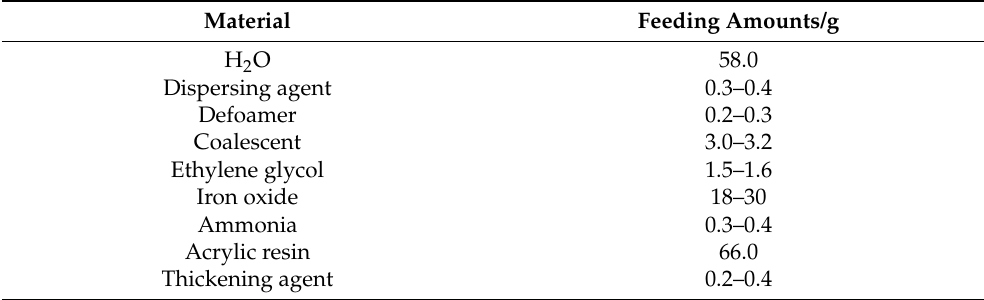
Table 1. Synthesis parameters of the La-doped α -Fe 2 O 3 -modified waterborne